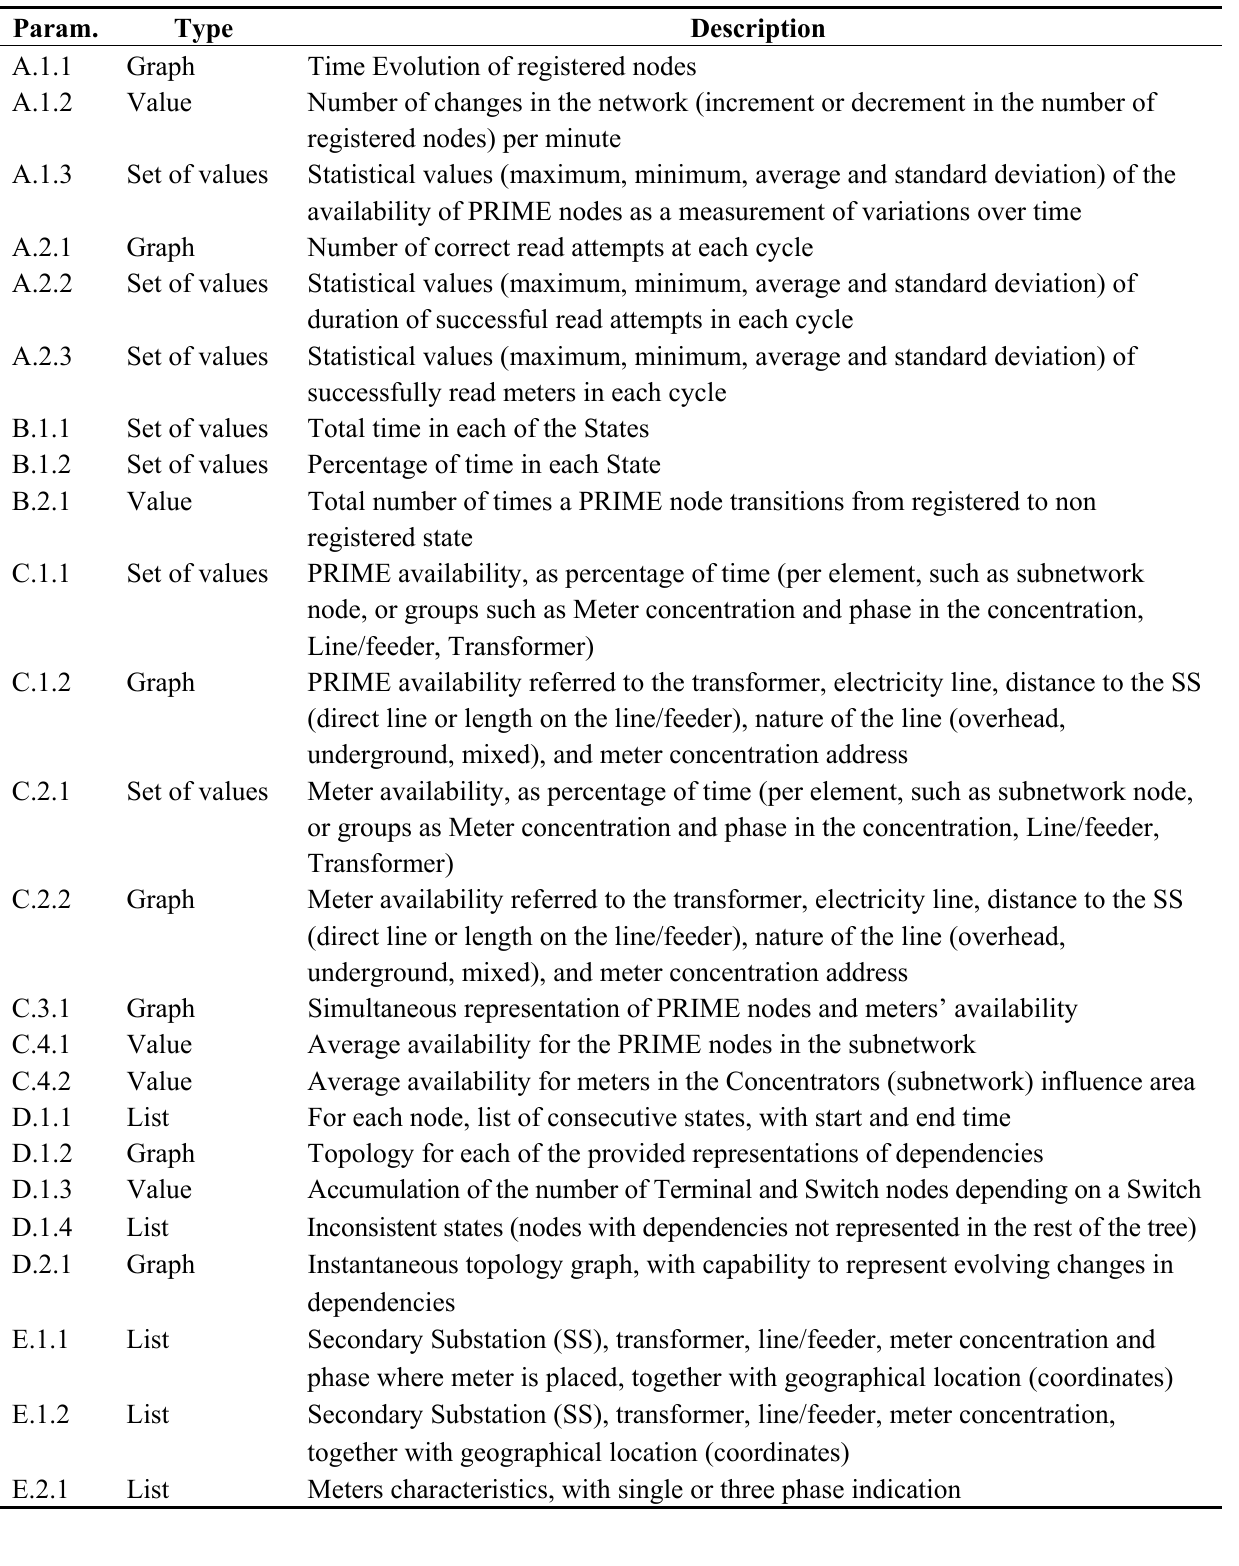
Table 6. Detailed parameters proposed for PLC based smart metering deployment analysis.